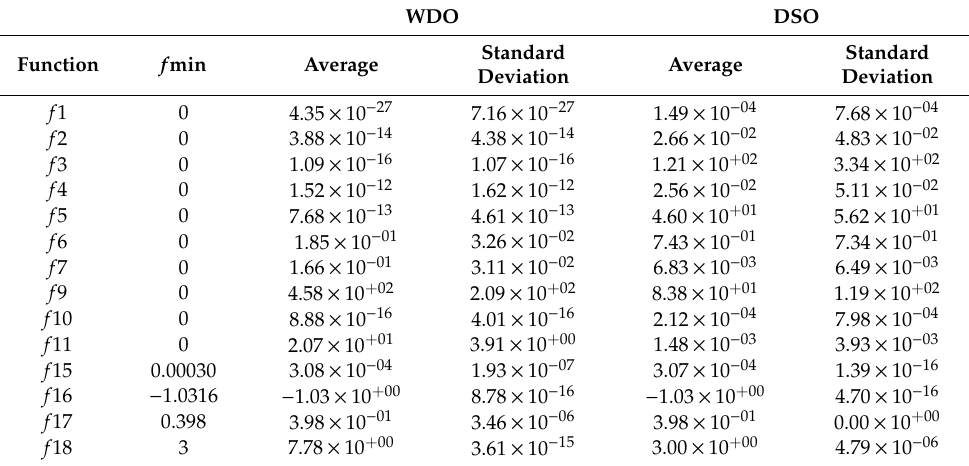
Table 11. Results for 128 dimensions.